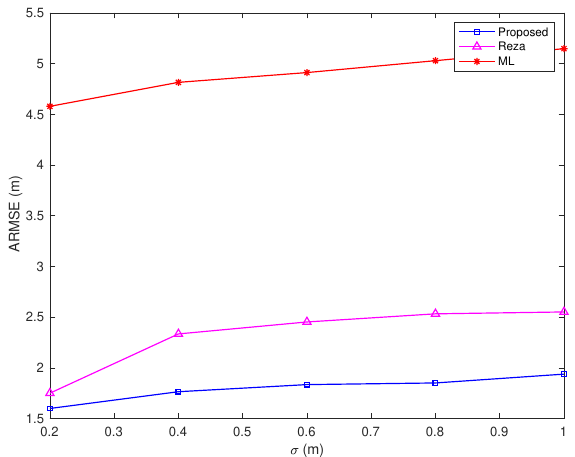
Figure 10. ARMSEs vs. σ ( B max = 10 m, and the percentage of NLOS links equals